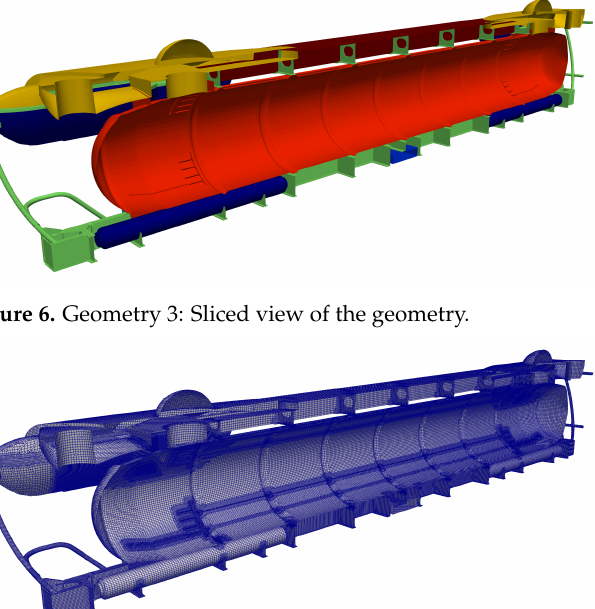
Figure 5. Geometry 3: Geometry of the pressure hull and exostructure used in the CFD simulation, bottom view.